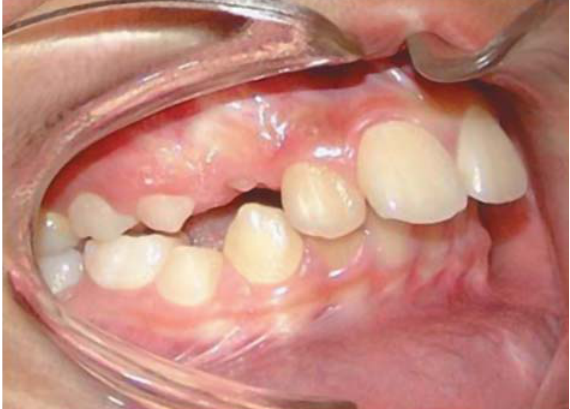
Figure 3- Pretreatment photograph of the